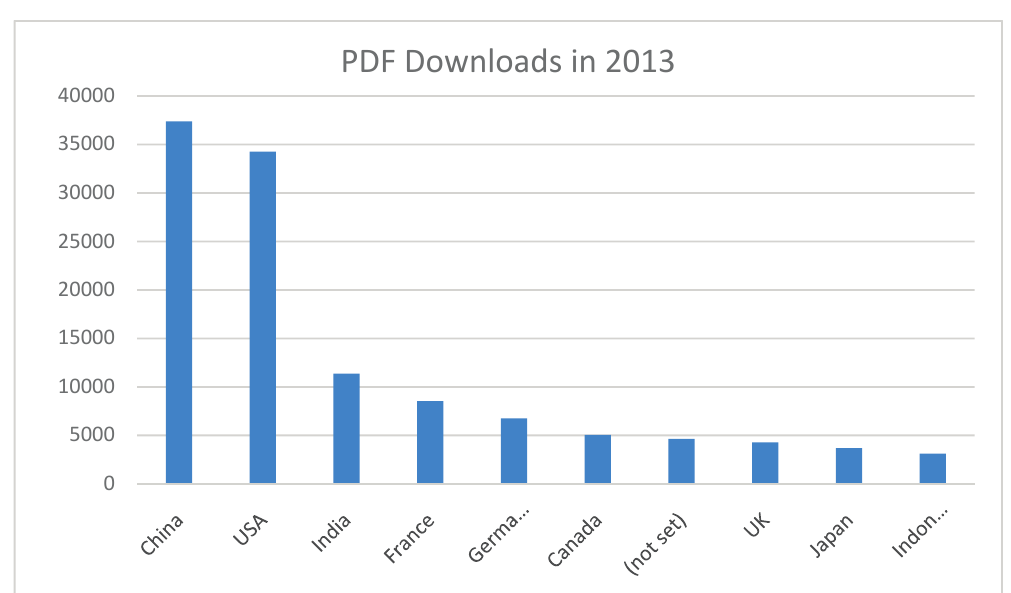
Figure 2. Geographical distribution of PDF downloads in 2013. China accounts 21.4%, as the country most frequently downloading papers from our journal, while 19.6% of downloads come from the